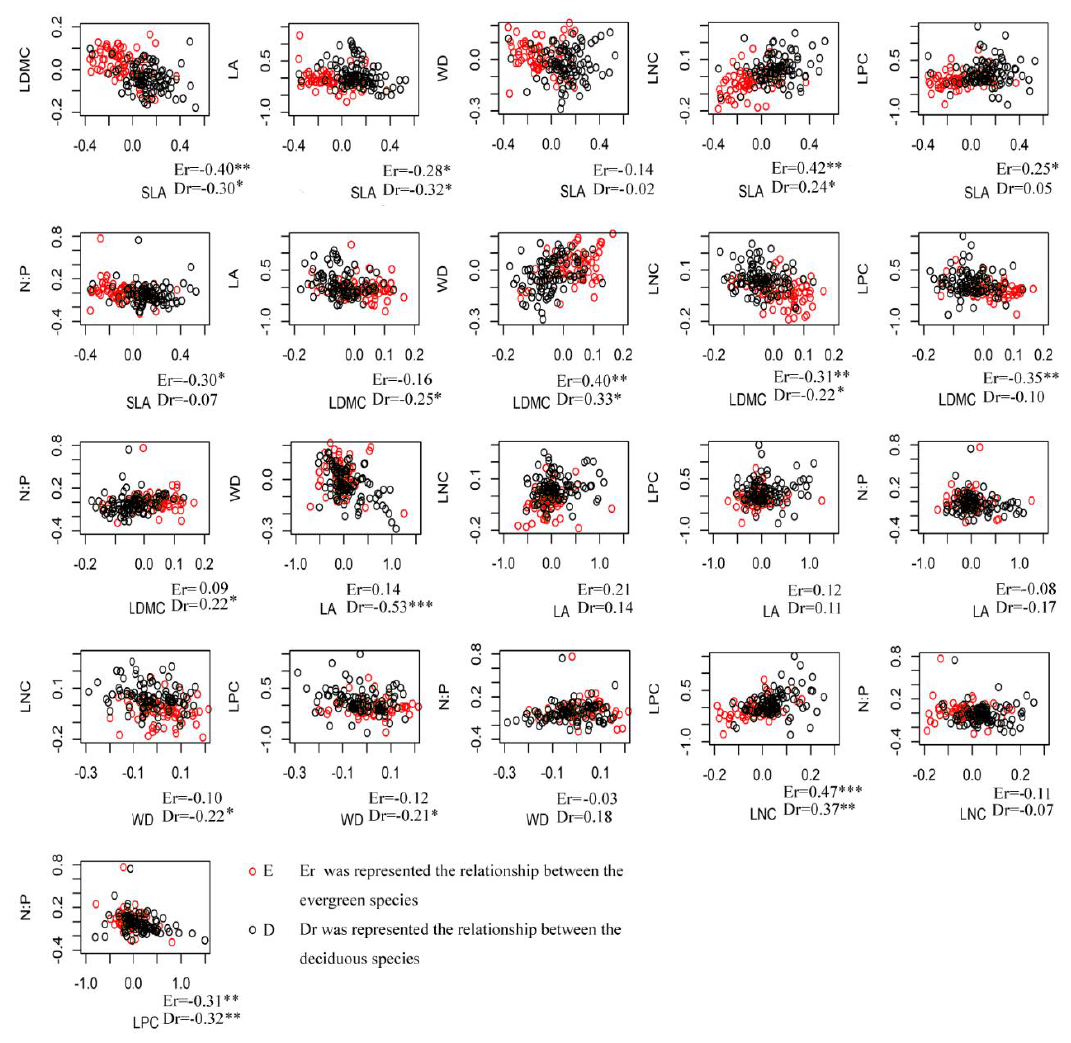
Figure 4. Scatterplots of species’ alpha trait values for all pairwise combinations of evergreen and deciduous species for the seven functional traits in a broadleaved mixed forest in Central China. (* p < 0.05; ** p < 0.01;*** p < 0.001).